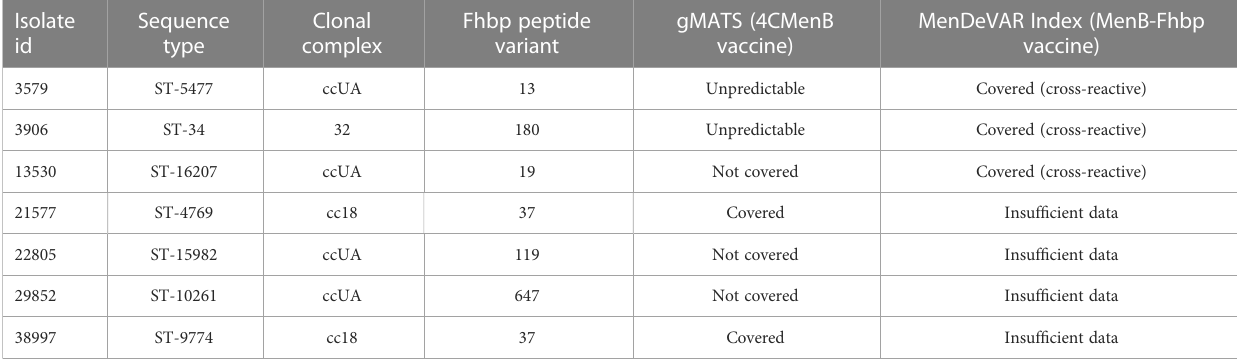
TABLE 6 4CMenB and MenB-Fhbp vaccine coverage predictions by the Fhbp antigen. Isolate